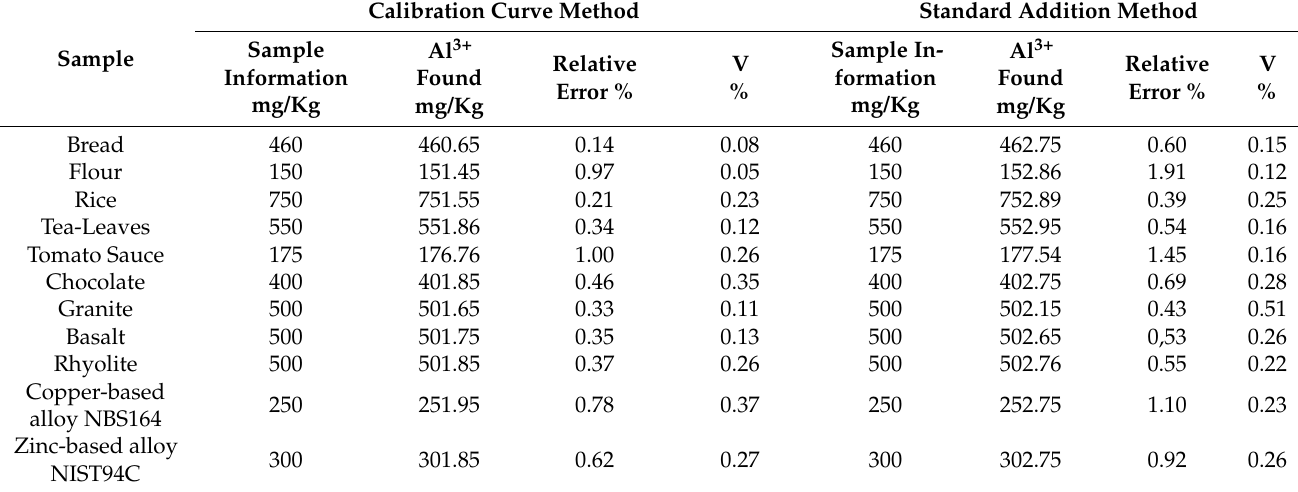
Table 3. Estimation of aluminum in foodstuff, real samples and standard alloys applying the proposed